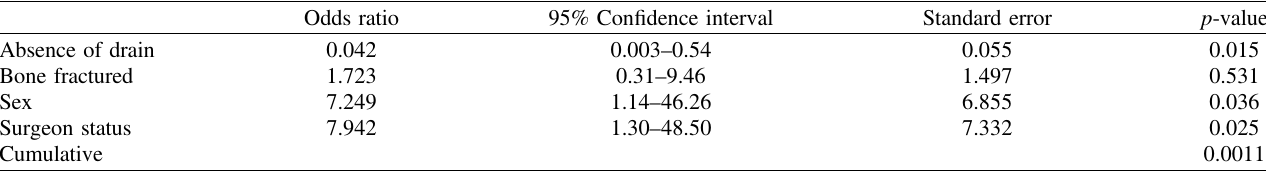
Table 3. Multivariate logistic regression model of baseline covariates associated with surgical site